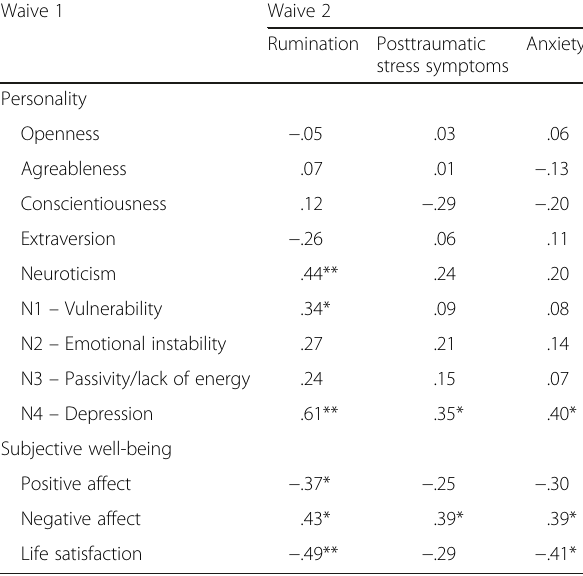
Table 1 Correlations between Waive 1 (personality, and subjective well-being) and Waive 2 (rumination, post-traumatic symptoms, and anxiety) measures ( N =